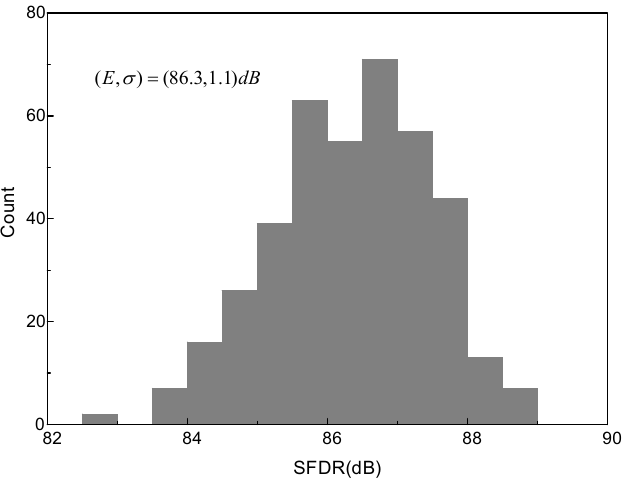
Figure 7. Histogram of output spectra’s SFDR with mismatch of 1% of sub ‐ ADC 5 MSBs.